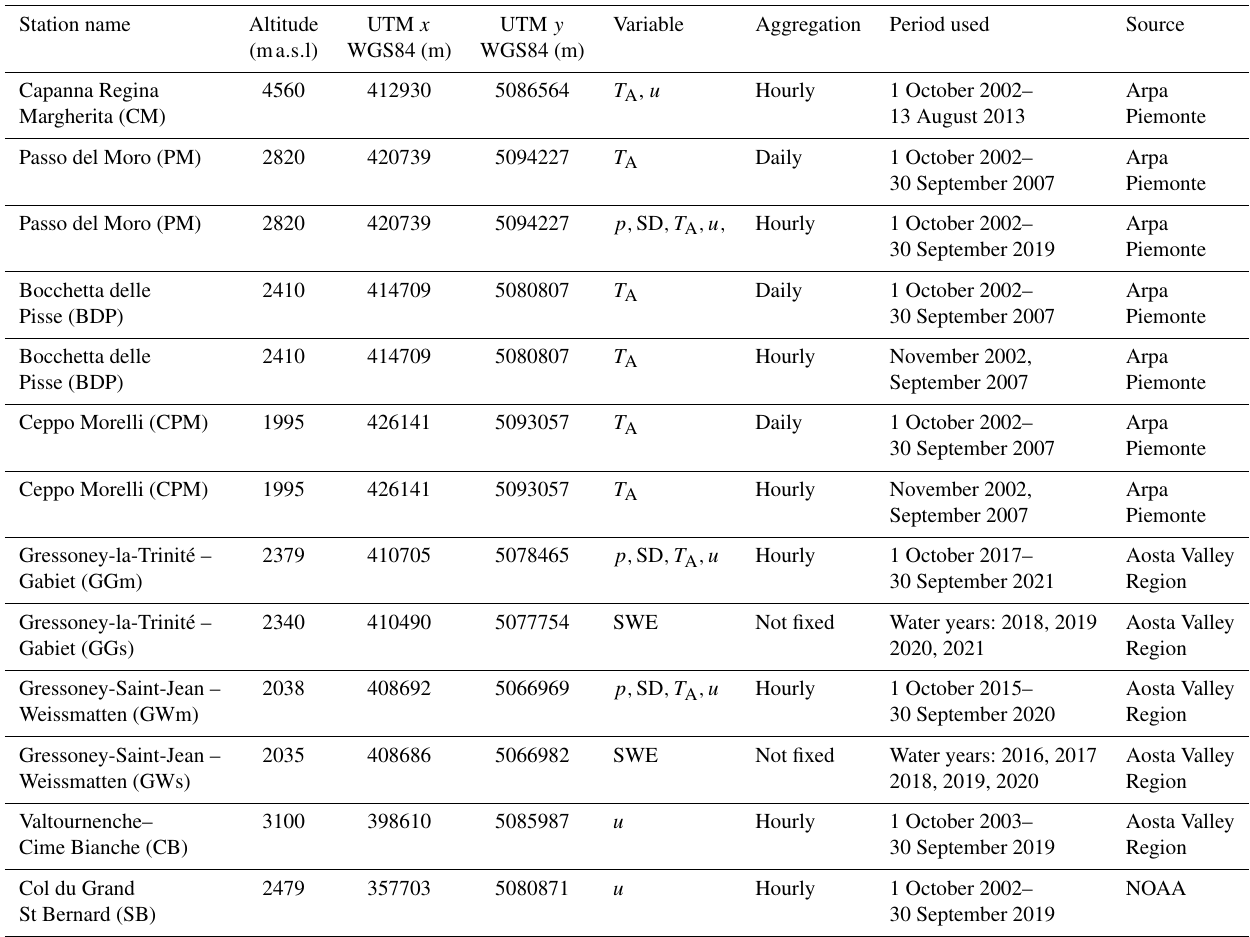
Table 1. Meteorological data employed in the case study ( p stands for precipitation, SD for snow depth, T A for air temperature, u for average wind speed and s for fresh snow). Hydrological years are identified by the last year; e.g. 2009 is hydrological year 2008–2009. With the term hydrological year we refer to the period from 1 October to 30 September of the next year.